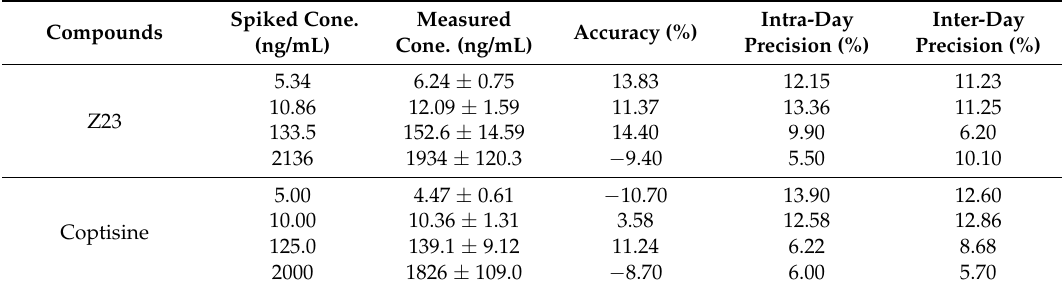
Table 2. Precision and accuracy of the determination of fourteen alkaloids in beagle plasma ( n = 18, 6 replicates per day for 3